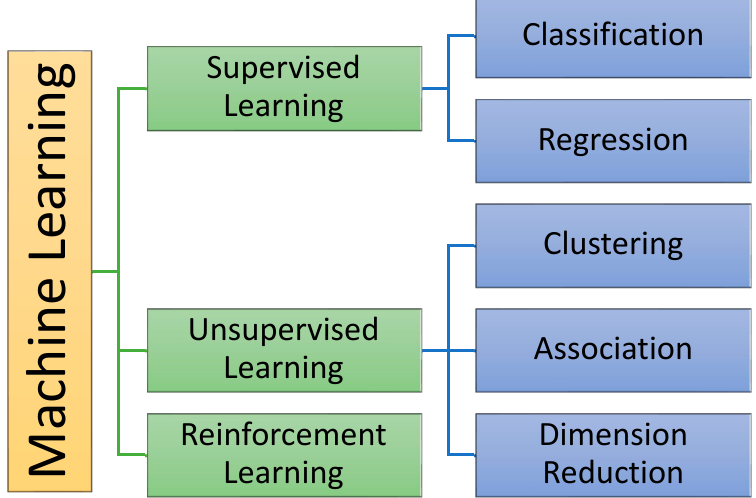
Figure 2. Types of learning are usually employed in Machine Learning.